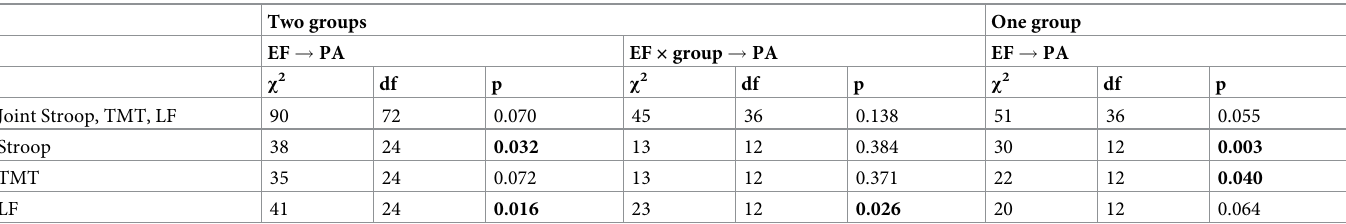
Table 4. Tests on effect constraints for executive functions on physical